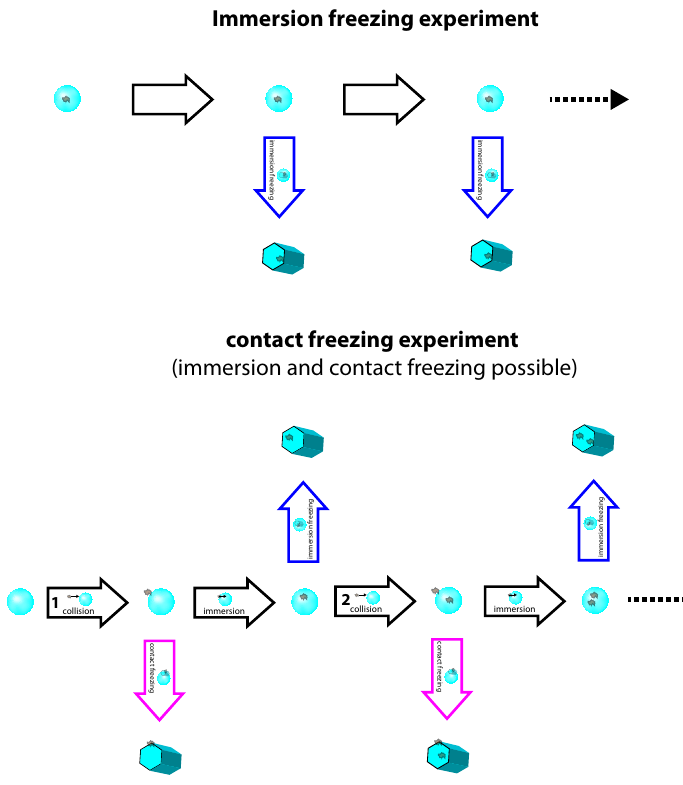
Fig. 15. Schematic of a typical contact and immersion freezing experiment. For details refer to the main